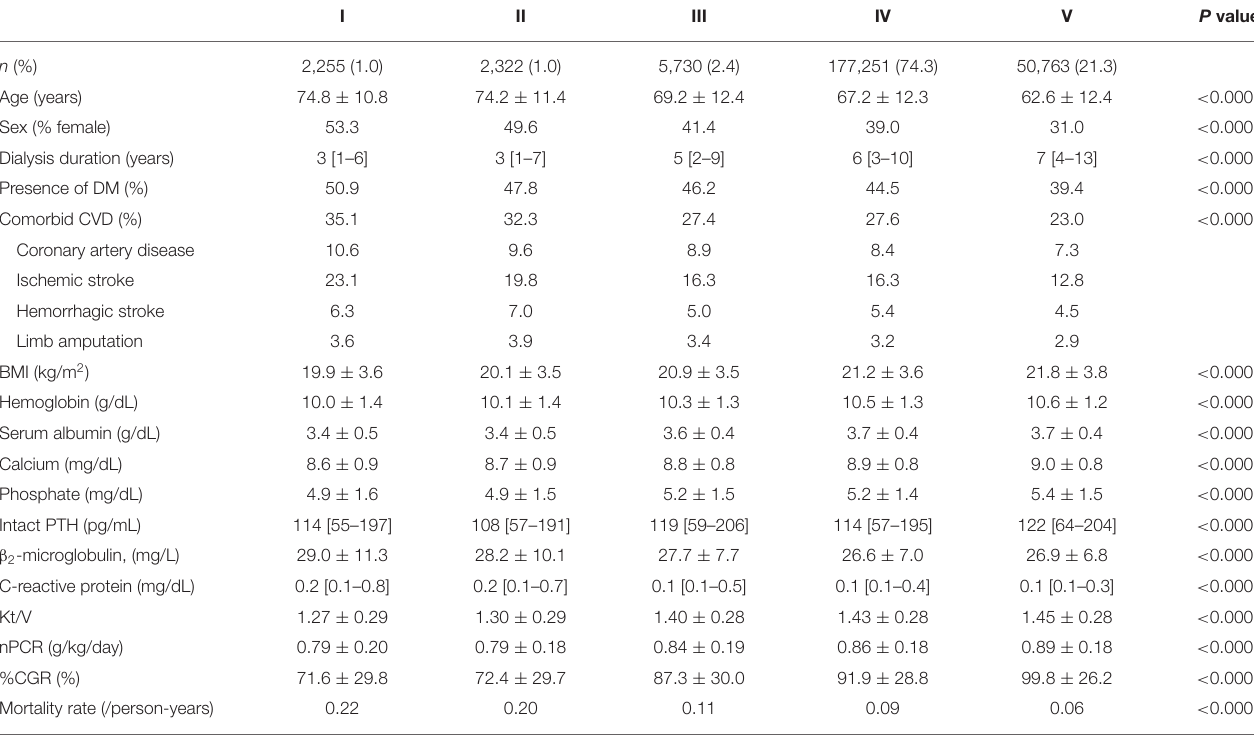
TABLE 3 | Demographic, clinical, and laboratory values in 238,321 hemodialysis patients according to dialyzer type in the Japanese classification. I II III IV V P